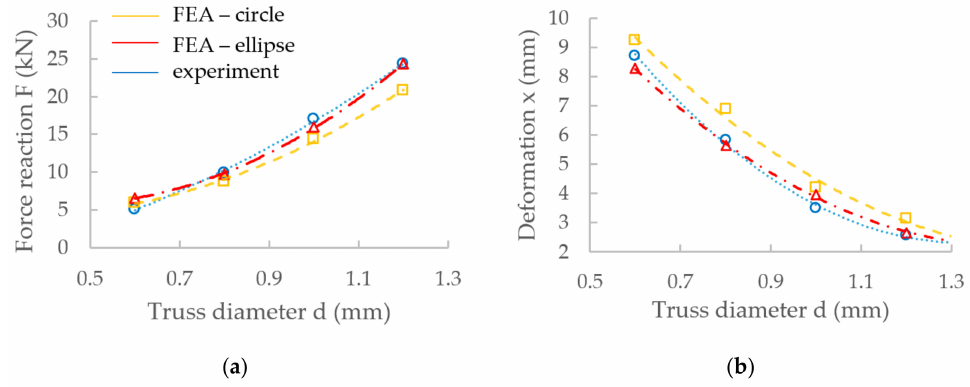
Figure 16. Comparison of FEA results and experiment for different strut diameters; ( a ) reaction force; and ( b )